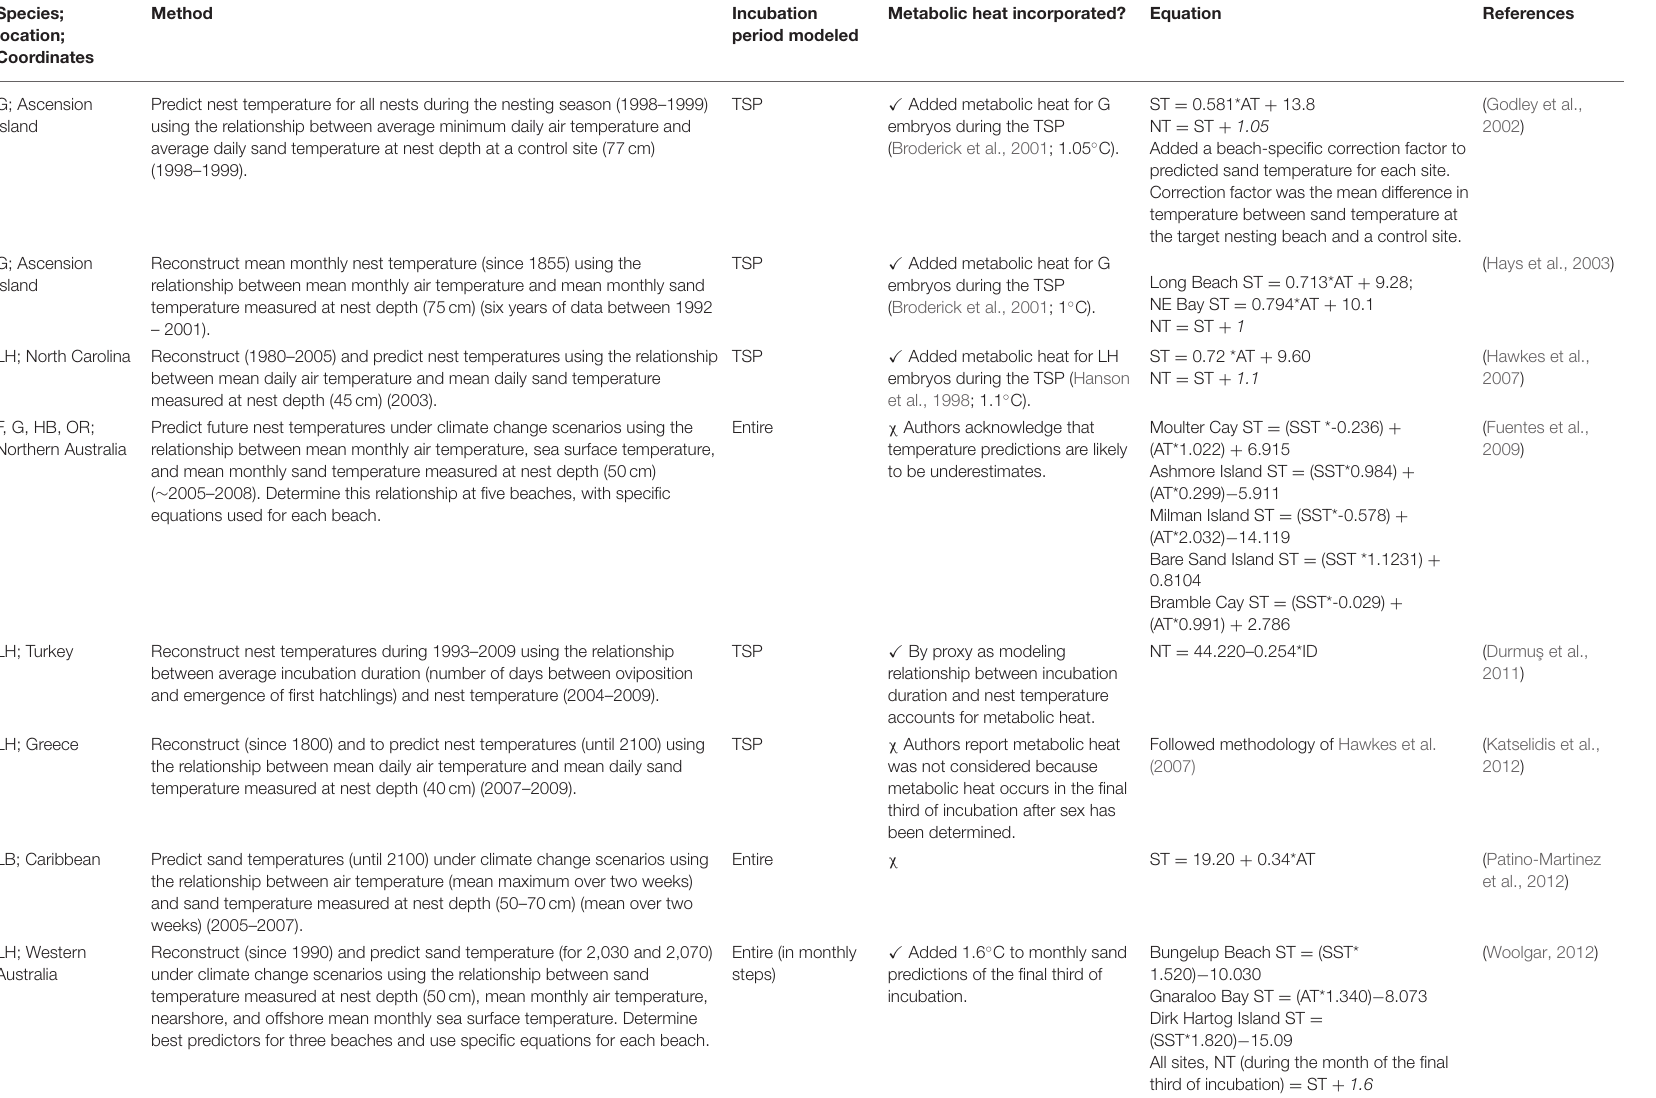
TABLE 1 | An overview of all correlative models used to predict the temperature of marine turtle nests, or sand temperature on nesting beaches, as generated by systematic review, and shown in chronological order. Species;